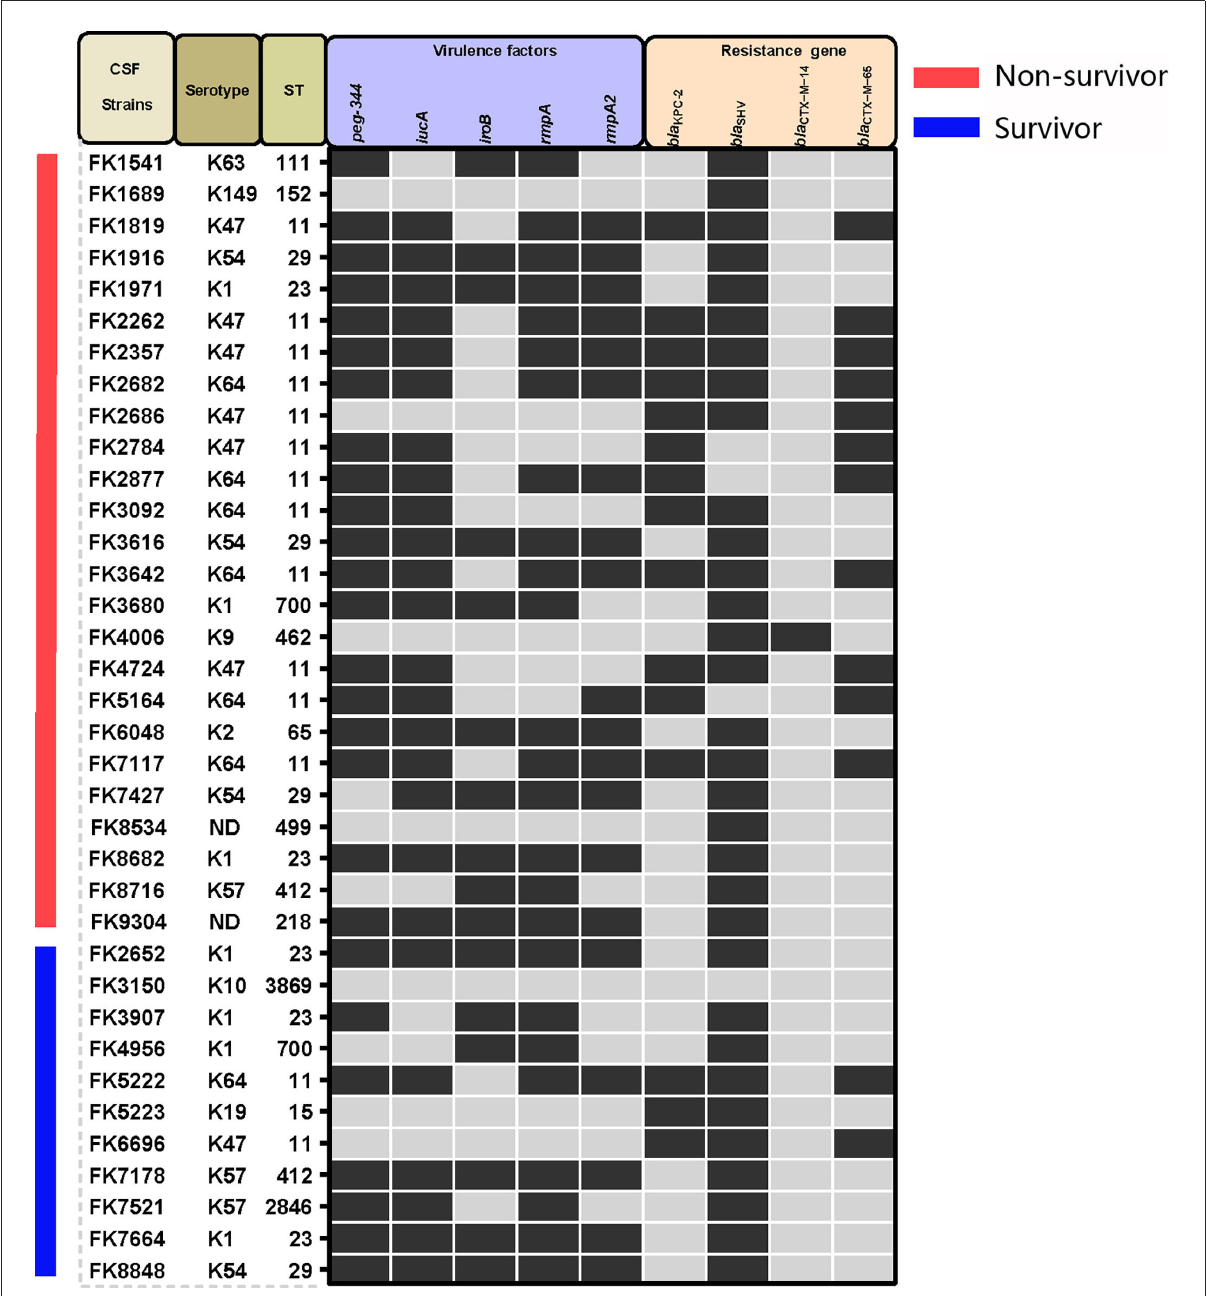
FIGURE1 Capsular serotypes, virulence genes, and resistance genes found in the K. pneumoniae strains in this study. Positive is represented by black squares, whereas negative is represented by gray squares.